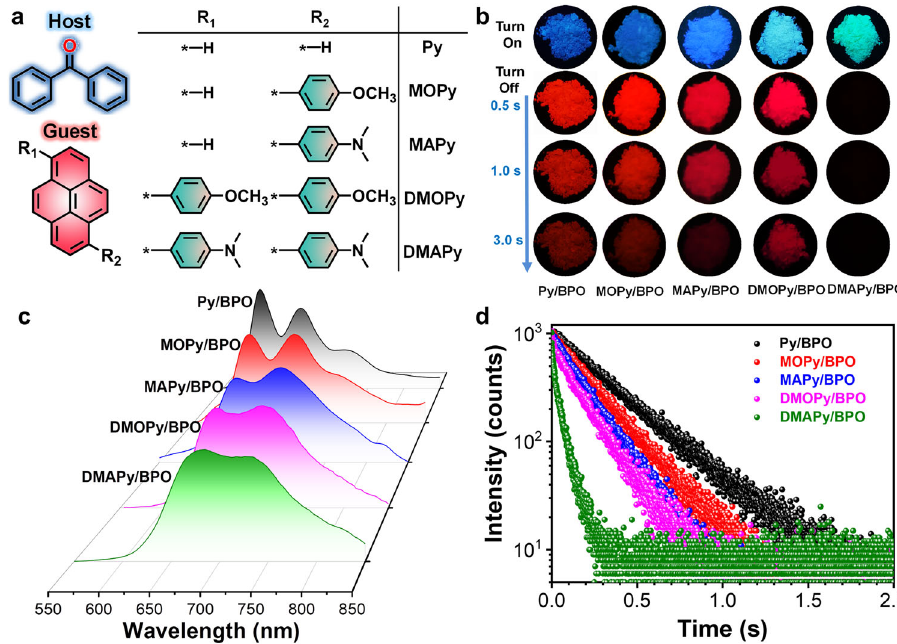
Fig. 2 Photoluminescence properties of the guest – host system. a Molecular structures of the guest and host molecules. b Fluorescence (top) and phosphorescence (down) images of the guest – host materials. c Phosphorescence spectra of host – guest materials. Excitation wavelength: 380 nm; Delayed time: 1 ms. d Phosphorescence decay curves of guest – host materials. Excitation wavelength: 380